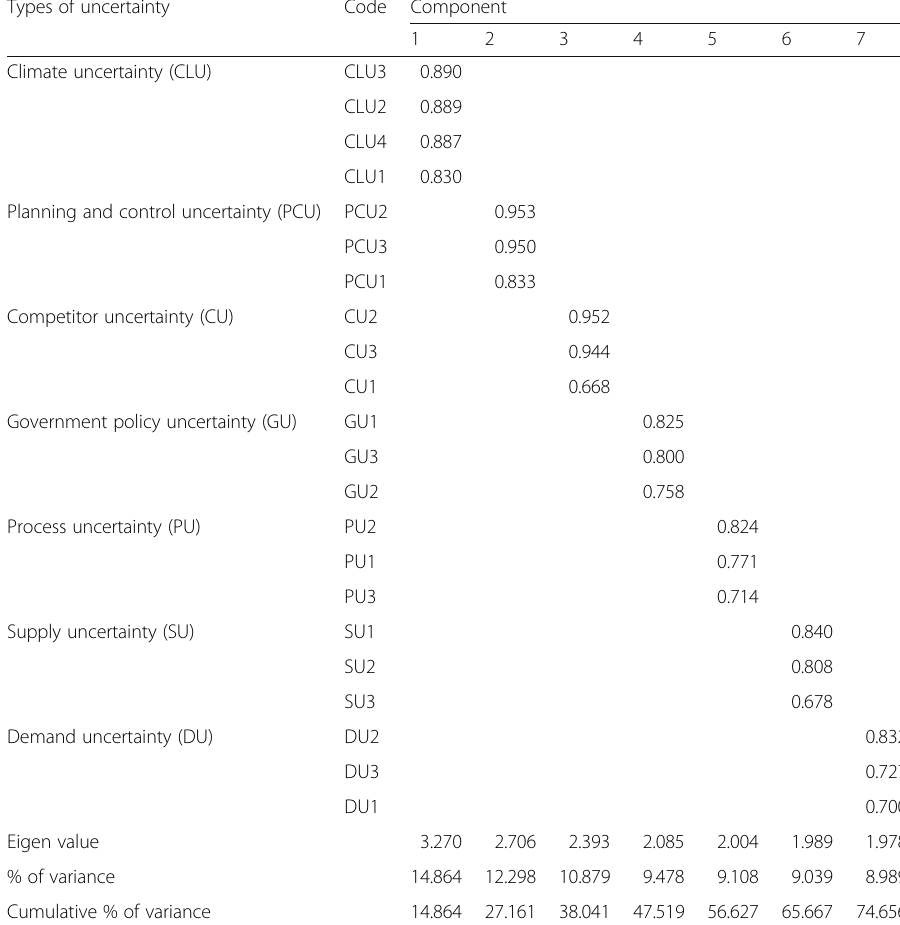
Table 5 Structure of rotated component matrix for the rice supply chain ( N = 215) Types of